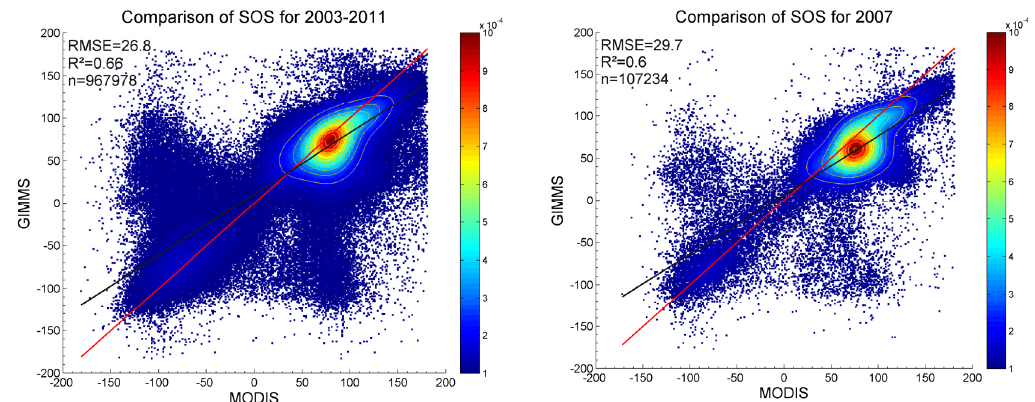
Figure 13. Scatterplots between the start of season from GIMMS vs. MODIS for full image extent and all observations. ( left ) data from 2003 to 2011 ( right ) only data from 2007. The 1-to-1 line (red) and the regression line (black) are also shown. Densities increase from blue to red.